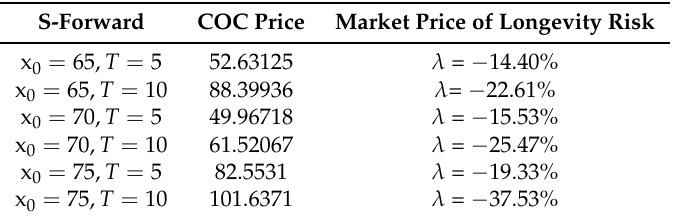
Table 6. Equivalent market price of longevity risk in the risk-neutral approach, HW model. S-Forward COC Price Market Price of Longevity Risk